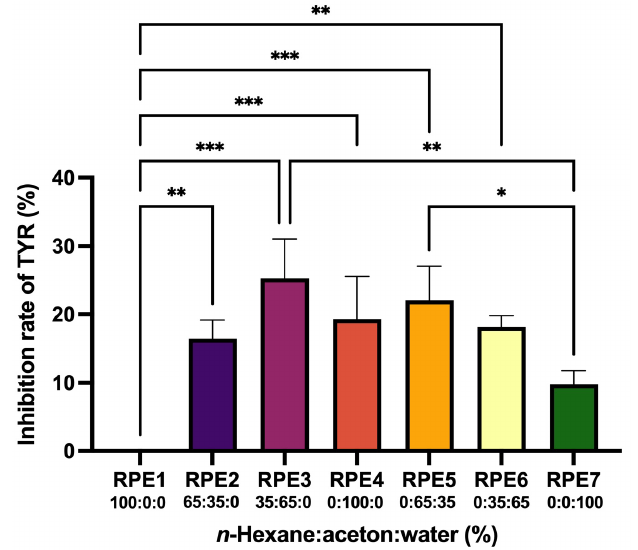
Figure 1. TYR-inhibition of different RPEs. RPE1 to RPE7 were extracts prepared by the mixture of n -hexane – acetone – water of different proportions. Inhibition of the positive control, KA at 0.94 μM, was 95.1 ± 0.4%. Mean value ± standard deviation was expressed ( n = 3). RPE, Rheum palmatum extract; TYR, tyrosinase. * p < 0.05, ** p < 0.01, and *** p < 0.001.